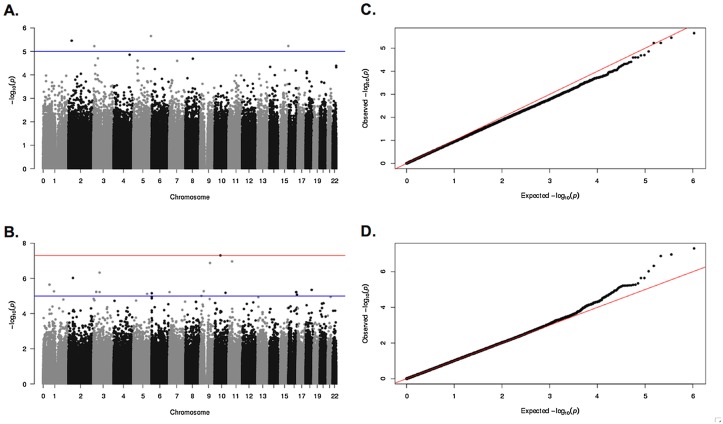
Results of the discovery GWAS.Manhattan plots (A and B) contain −log P values (y-axis) associated with 8-week change in FEV1 after montelukast treatment, for 532,264 genotyped SNPs organized by chromosome (x-axis), for LOCCS (A) and LODO (B). The threshold for genome-wide significance and suggestive genome-wide significance are indicated as blue and red lines, respectively, in the Manhattan plots. Q-Q plots (C and D) demonstrate the observed −log P values vs. expected −log P values, for SNPs from LOCCS (C) and LODO (D) populations. In all plots, individual SNPs are represented as filled circles.